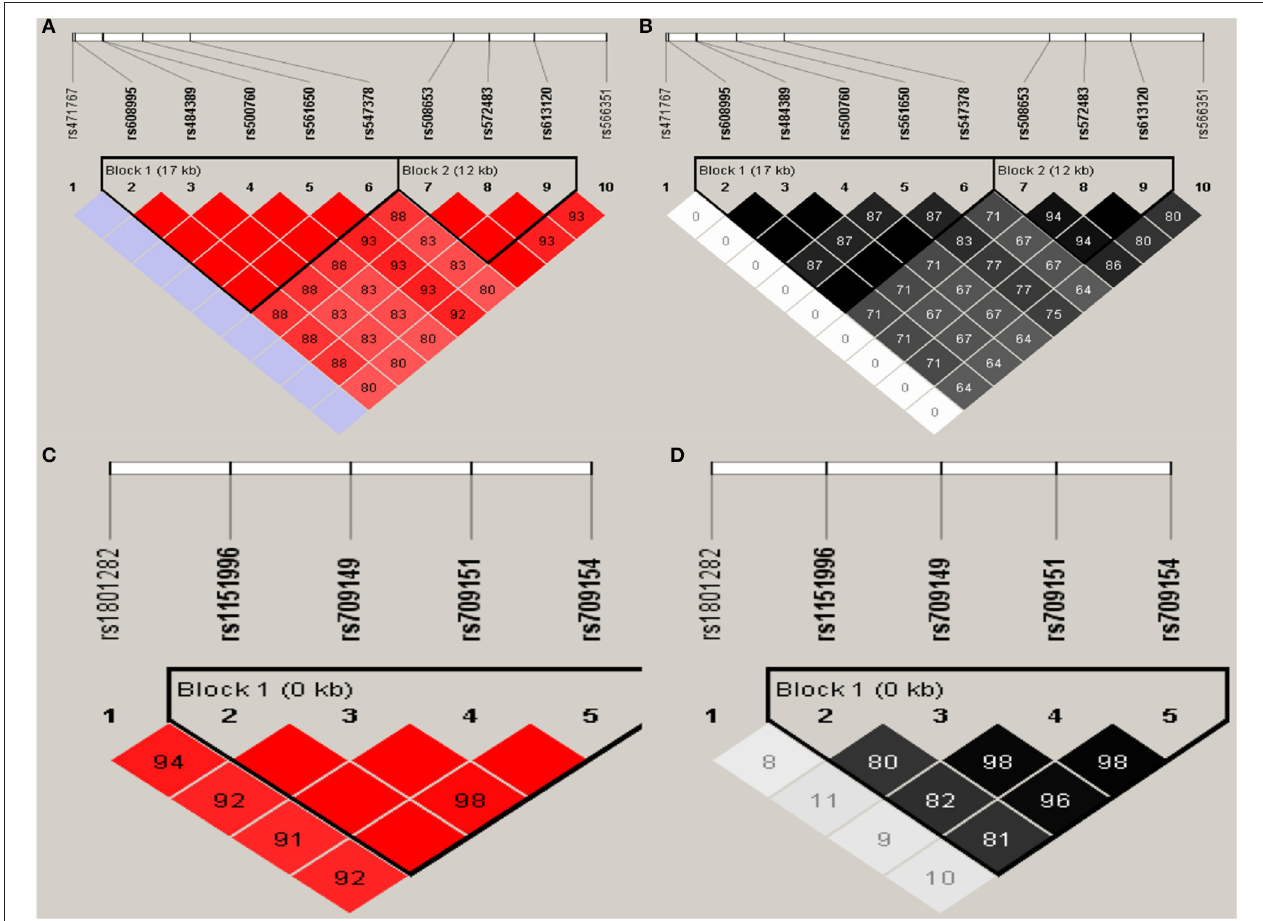
FIGURE 3 | Graphical representations of the SNP locations and LD structure of PGR (A,B) and PPARG (C,D) using tested genotyped SNPs in 331 controls.